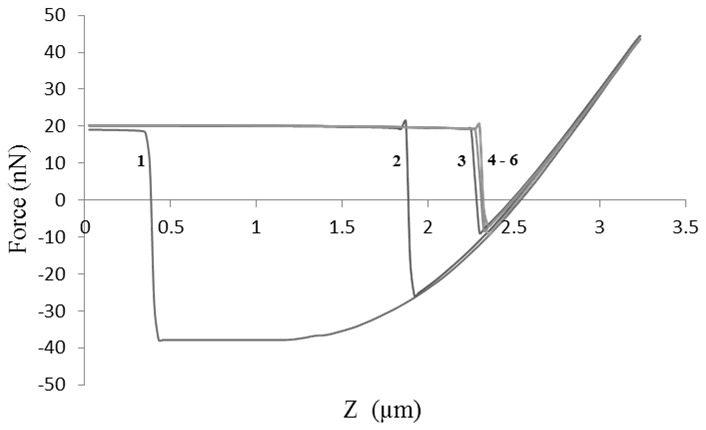
Changes in AFM adhesion force upon indentation of ibuprofen particle.The graph shows the retraction part of the curve used to obtain adhesion force. The force was decreased upon subsequent indentations (from 1 to 3) followed by a constant force indicated by the overlap at indentations 4 to 6.